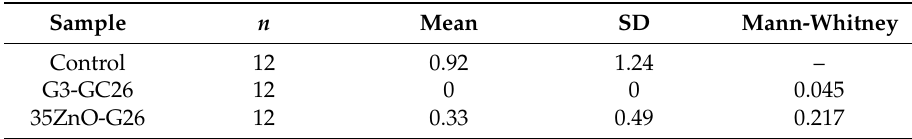
Table 3. Mean values of bone loss at distal and mesial aspect of teeth filled with different restorative materials in Class V preparations.